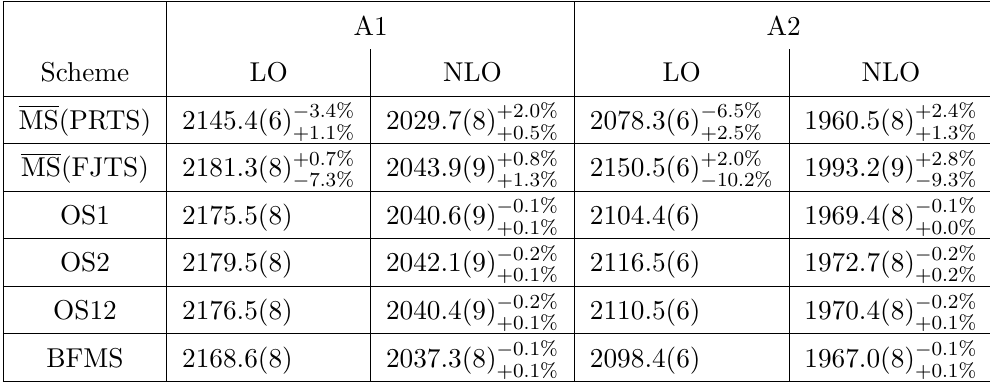
Table 13 . LO and NLO integrated cross sections (cid:27) [fb] for the production of the light Higgs boson in VBF, pp H 2 jj + X , for the THDM scenarios A1 and A2 in di(cid:11)erent renormalization schemes, ! with the OS12 scheme as input scheme (and full conversion of the input parameters into the other schemes). The scale variation (given in percent) corresponds to the scales (cid:22) = (cid:22) 0 = 2 and (cid:22) = 2 (cid:22) 0